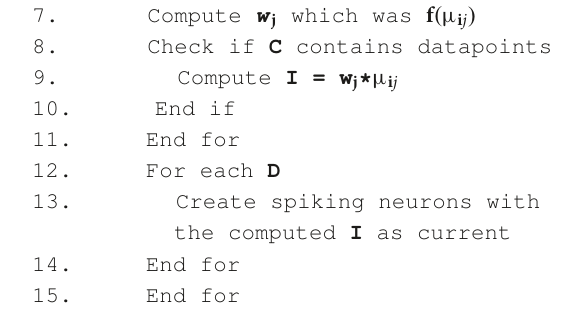
Algorithm 2: Cerebellum inspired spiking neural